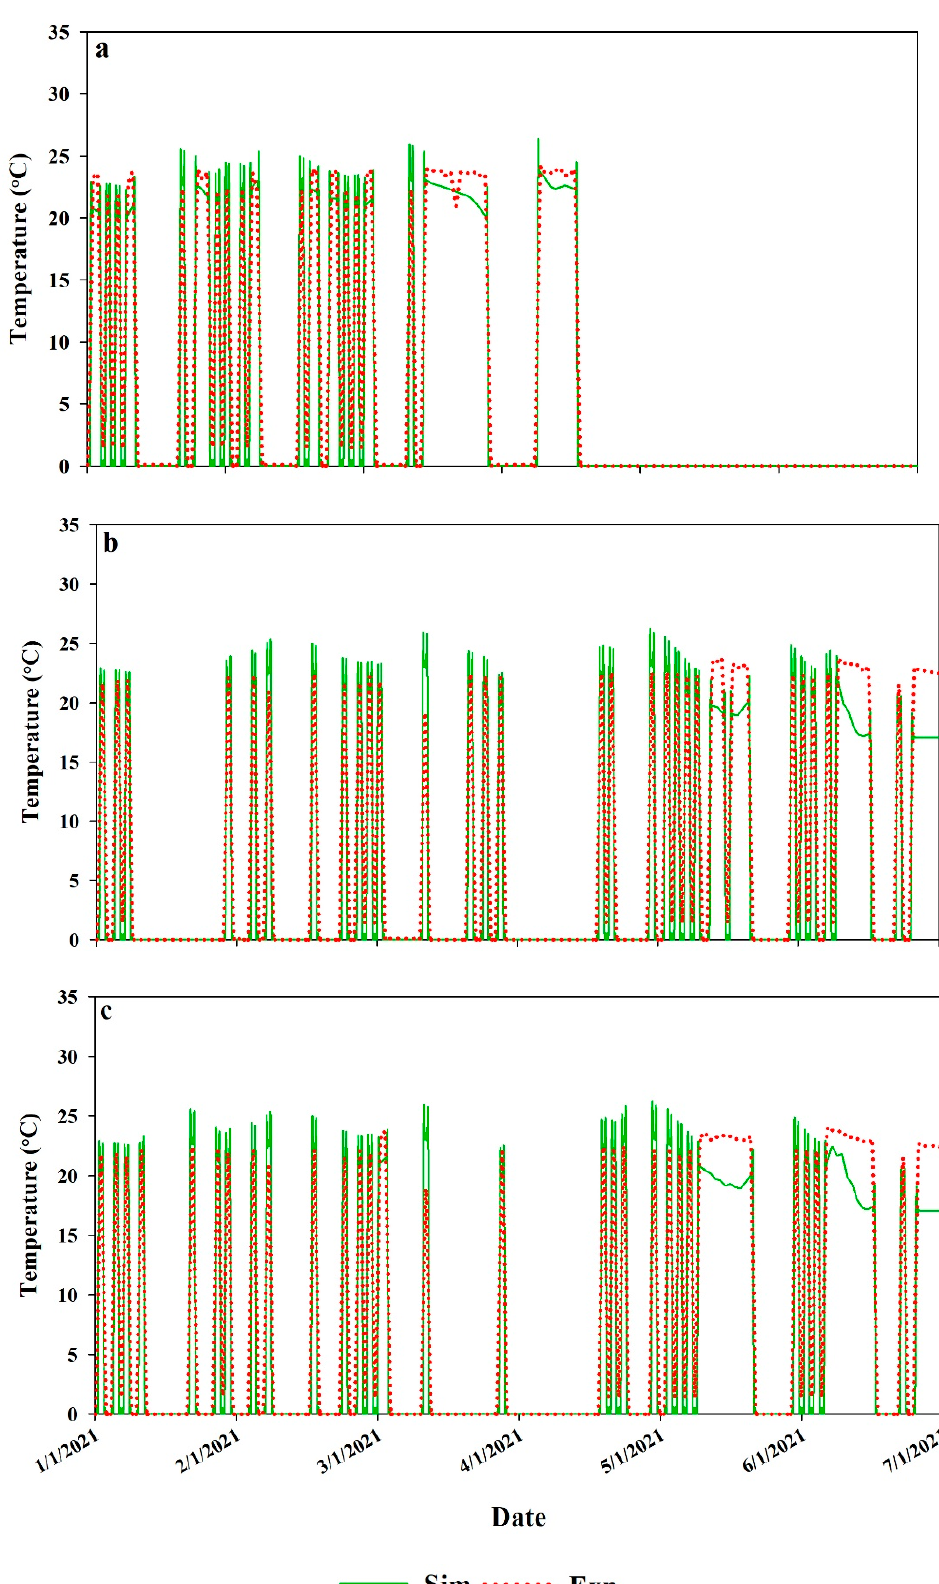
Figure 13. Heat pump output water temperature validation.